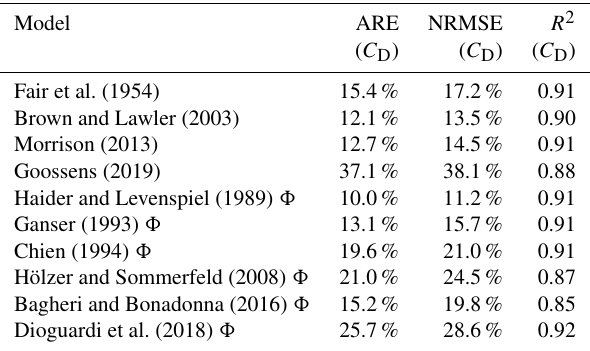
Table 5. Drag coefficient prediction accuracy for calcite pellets (0.36 <d p < 2.8mm) based on individual terminal settling exper- iments ( N =